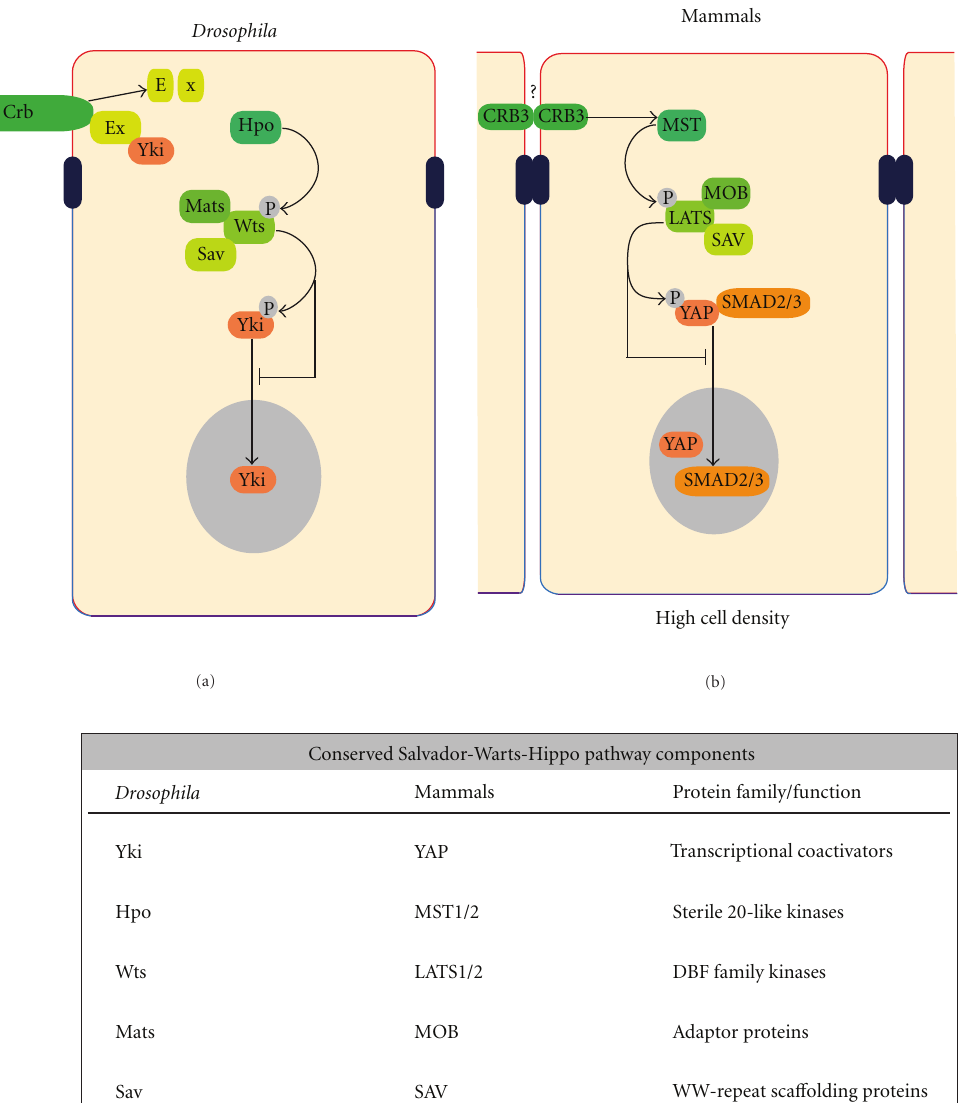
Figure 2: Functional relationship linking Crb proteins to the SWH pathway. (a) In Drosophila , nuclear Yki promotes cell proliferation and survival by modulating gene expression. Activation of the SWH pathway leads to the phosphorylation and cytoplasmic retention of Yki. Binding to the FERM domain protein Ex also prevents the nuclear translocation of Yki. Crb restricts Yki-dependent tissue hyperplasia by contributing to Ex localization and function. Overexpression of Crb leads to degradation of Ex, suggesting that Crb plays a crucial role in the fine-tuning of the SWH activity by activating Ex, while limiting its level. The table lists the components of the SWH pathway in Drosophila and mammals. (b) In mammalian cells, high cell density activates the SWH pathway, which contributes to contact-mediated inhibition of growth. Phosphorylation of YAP also results in cytoplasmic sequestration of SMAD proteins, thus limiting TGF- β responsiveness. CRB3 is important to couple cell density information to the SWH, perhaps through a homophilic interaction, leading to the suppression of TGF- β signaling and epithelial to mesenchymal